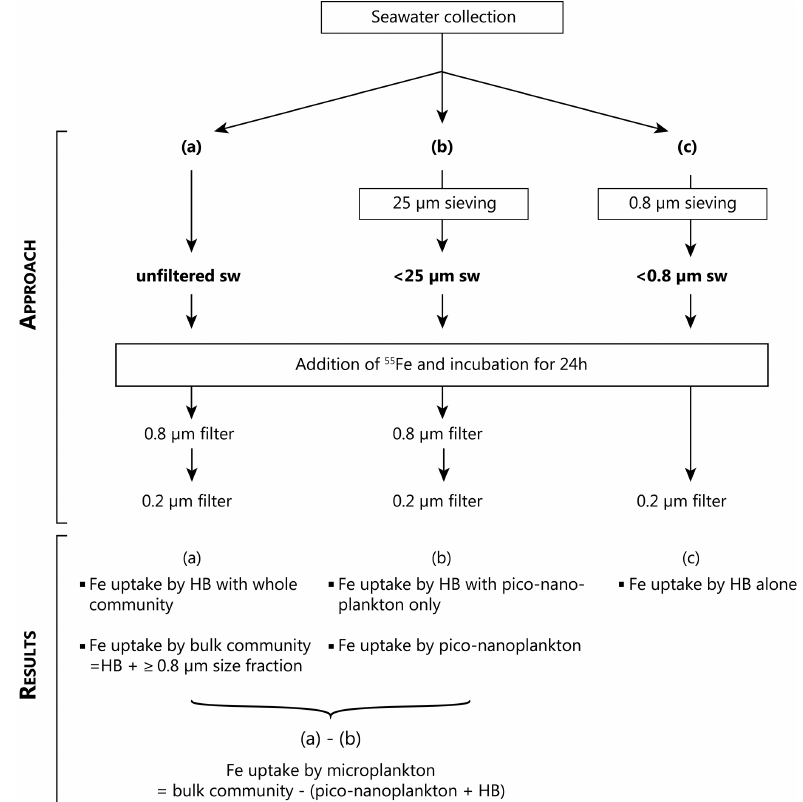
Figure 2. Schematic representation of experiments to determine Fe uptake by heterotrophic bacteria (0.2–0.8µm), pico-nanoplankton (0.8– 25µm) and microplankton ( > 25µm) during the KEOPS2 cruise (sw: seawater; HB: heterotrophic